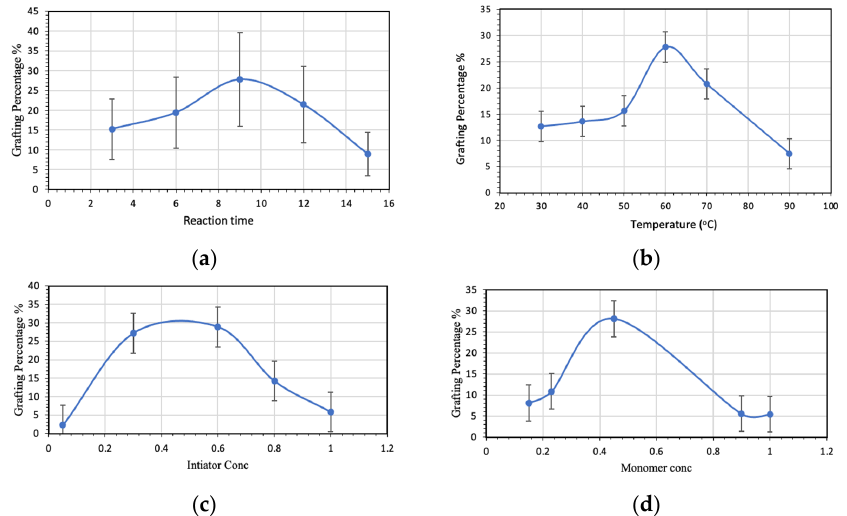
Figure 12. Effect of ( a ) reaction time, ( b ) temperature, ( c ) initiator concentration and ( d ) monomer concentration on the grafting percentage of starch g (MA-DETA) copolymer (starch = 2 g, [M] = 0.45 mol/L and [I] = 0.3 mol/L).